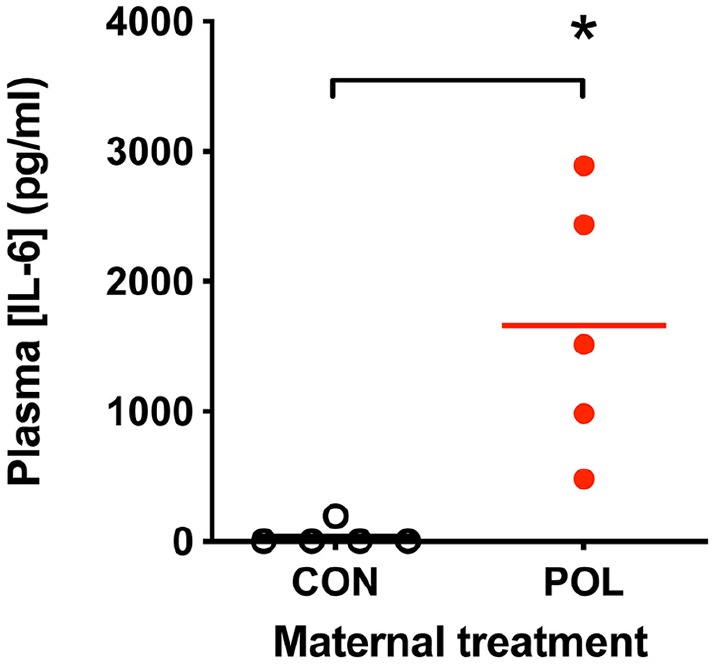
Significant increases in circulating maternal IL-6 levels 3 h post-poly(I:C) (POL) injection (plasma samples from n = 5 dams; 10 mg/kg i.p. administered on GD15) as compared to saline-injected dams (CON; plasma samples from n = 5 dams; sterile saline, i.p.) determined using ELISA-based assay.Data shown are IL-6 levels in pg/mL, *p < 0.05; 2-tailed student’s t-test.